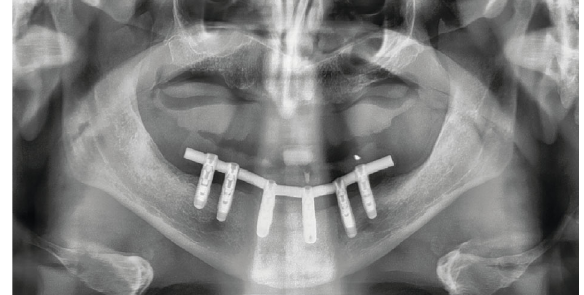
Figure 8: Radiographic panoramic control. After 6 years, bone level was